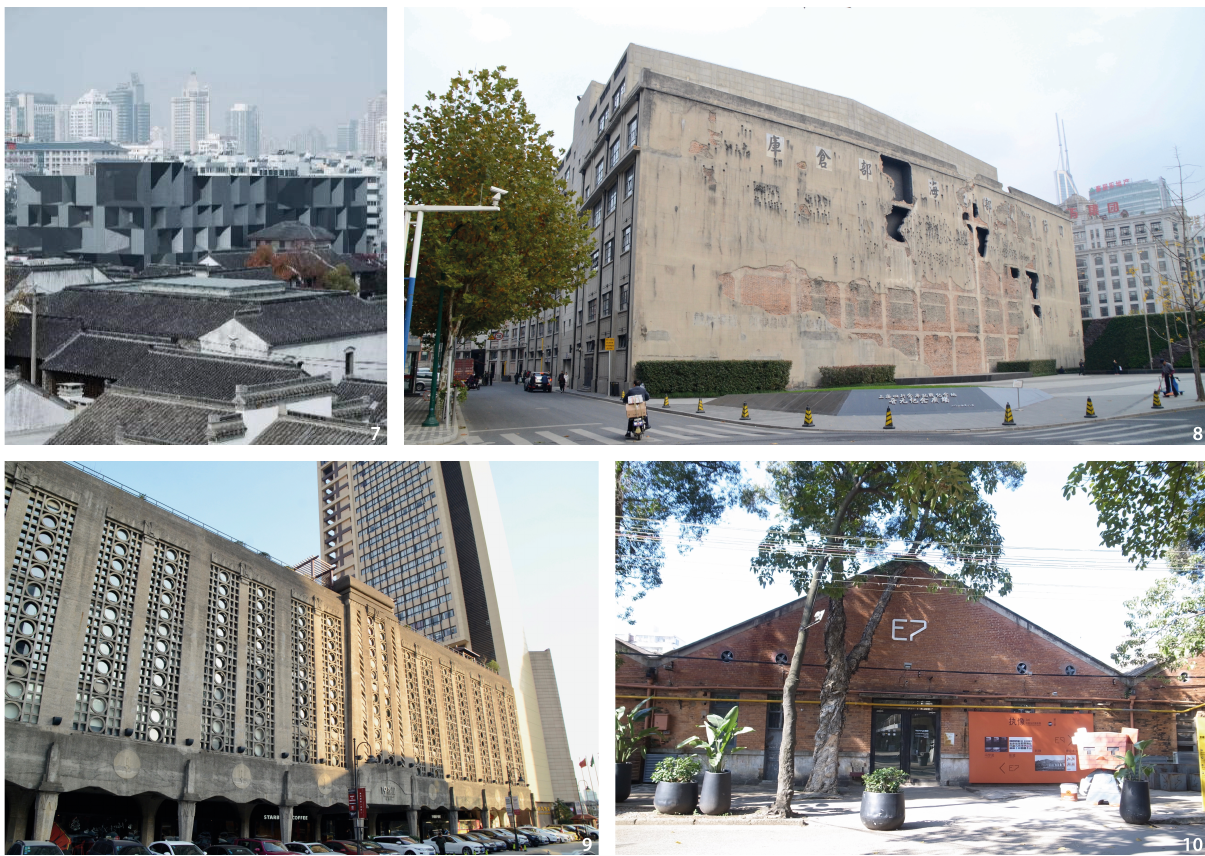
Figure 7 Jinling Art Museum in Nanjing, designed by Liu Kecheng, 2011 (Source: UED). Figure 8 The west wall of the Warehouse of Four Banks in Shanghai, designed by Guoliang Liu etc. 2014 (Source: Zijie Zhao). Figure 9 Old Millfun in Shanghai, Designed by Chongxin Zhao etc., 2007 (Source: Zijie Zhao). Figure 10 Redtory Culture Industrial Park in Guangzhou, 2009 (Source: Subin